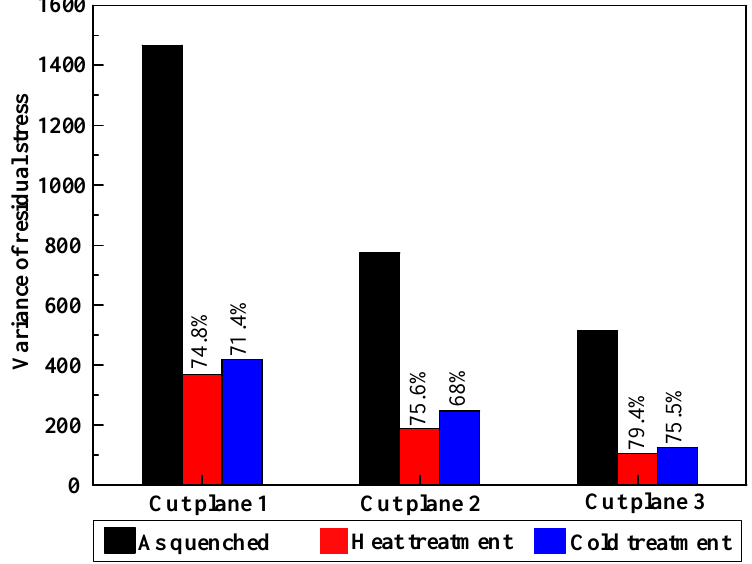
Figure 15. The variance of residual stress on each cut plane in different condition.